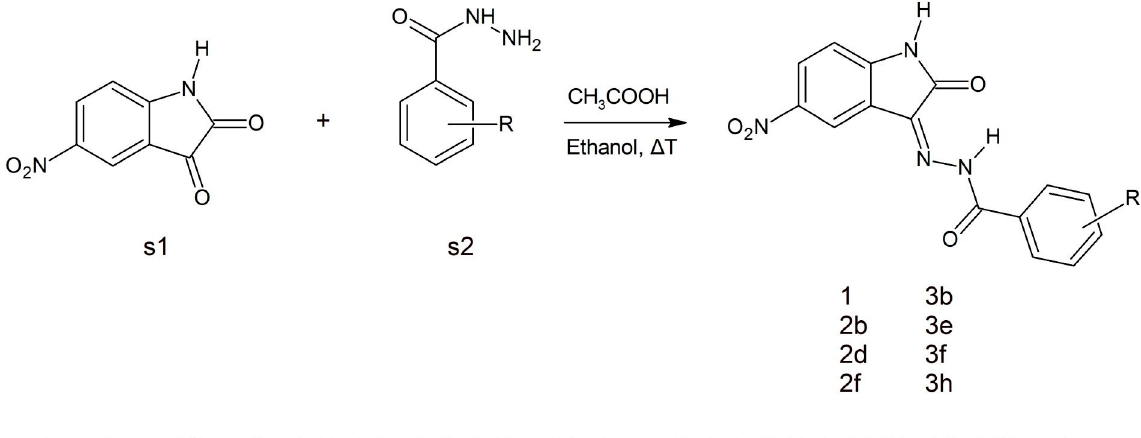
Table 6. Energies of cis- and trans -isomers of 5-nitroisatin-based benzoylhydrazines estimated in DMSO at the B3LYP/6-311 ++ G(d,p) level of theory. ∆ E CIS-TRANS represents the difference between cis- and trans- isomers ( ∆ E CIS-TRANS = E CIS − E TRANS